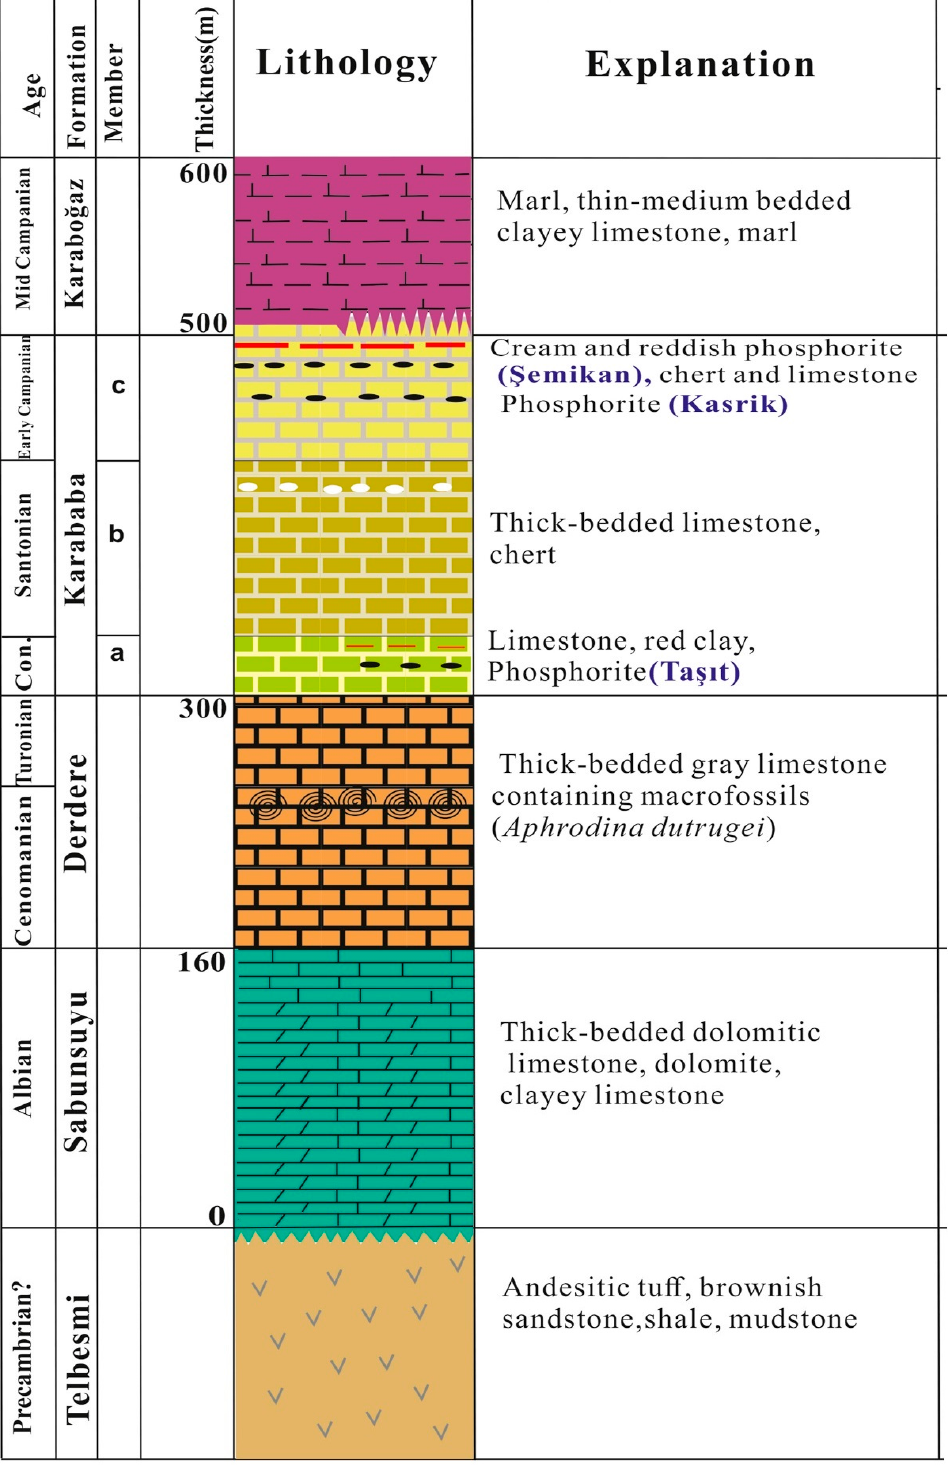
Figure 3. Stratigraphic columnar section of Derik–Maz ı da ğ ı region (taken from [6]).